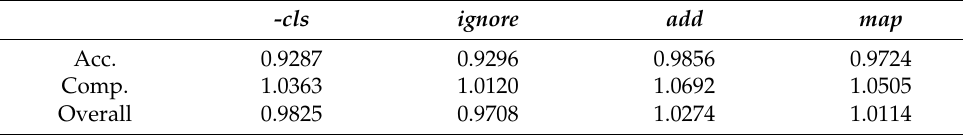
Table 4. Ablation study on the learnable token and image-like fusion methods.